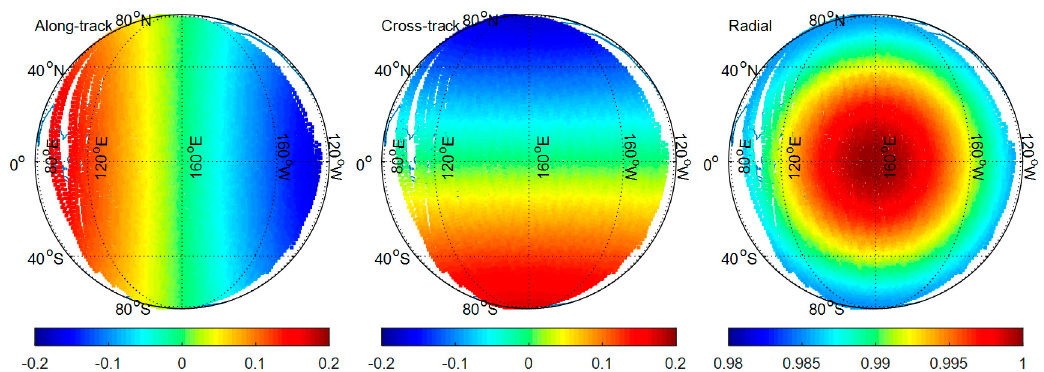
Figure 3. Magnitudes of distance errors along with the sight from FY-3C to C04 caused by unit orbit biases in the observable region for C04 during July 2017 looking down on the Earth from the perspective of C04. The left, center, and right are impact factors of C04 orbit biases in along-track, cross-track, and radial components, respectively.